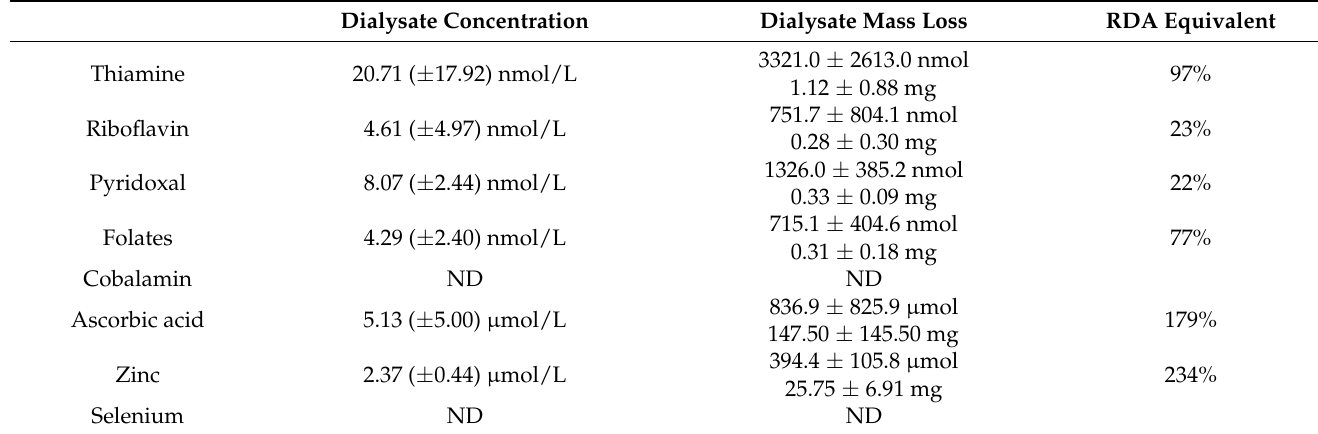
Table 3. Vitamins and trace elements parameters in